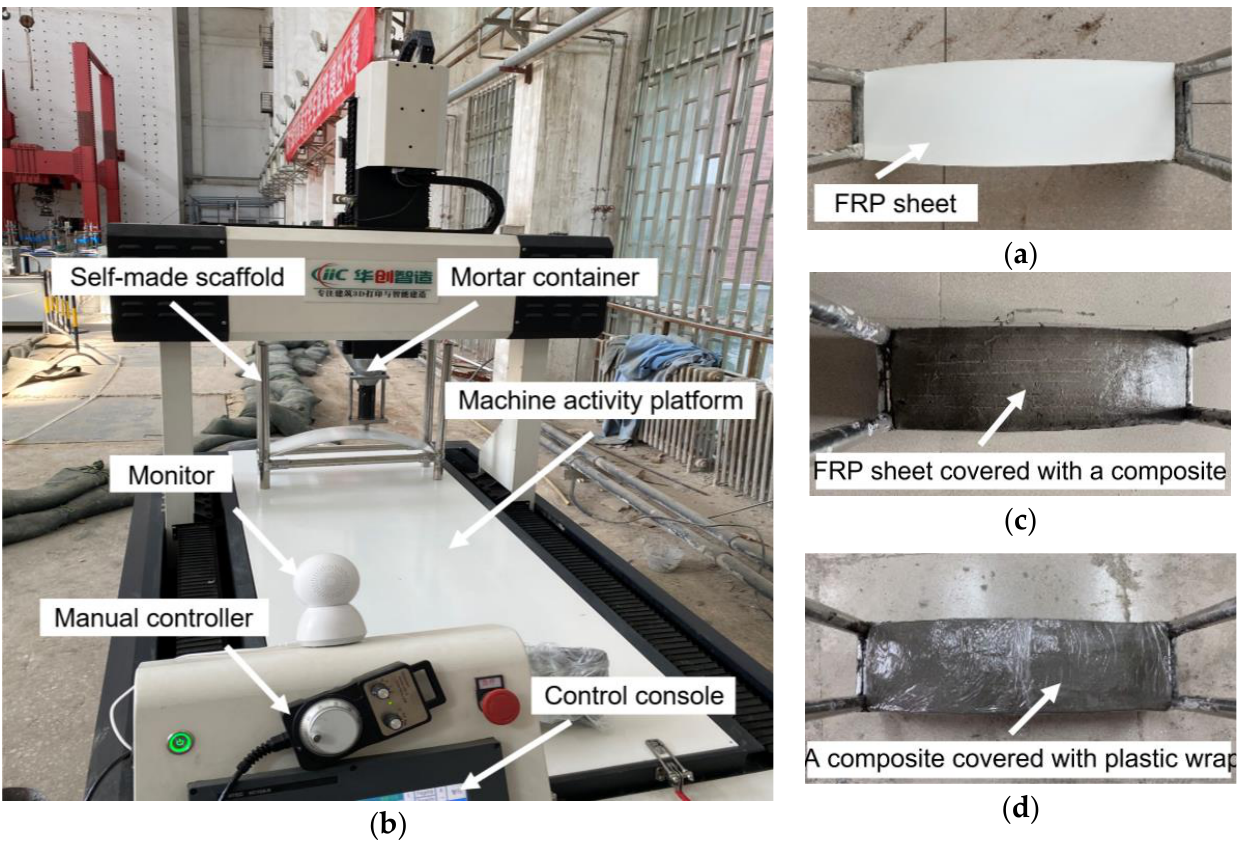
Figure 2. Production process of 3DPC thin-shell structure: ( a ) FRP sheet fixed on the self-made scaffold; ( b ) 3D printer HC 1009; ( c ) FRP sheet covered with a composite; ( d ) A composite covered with plastic wrap.